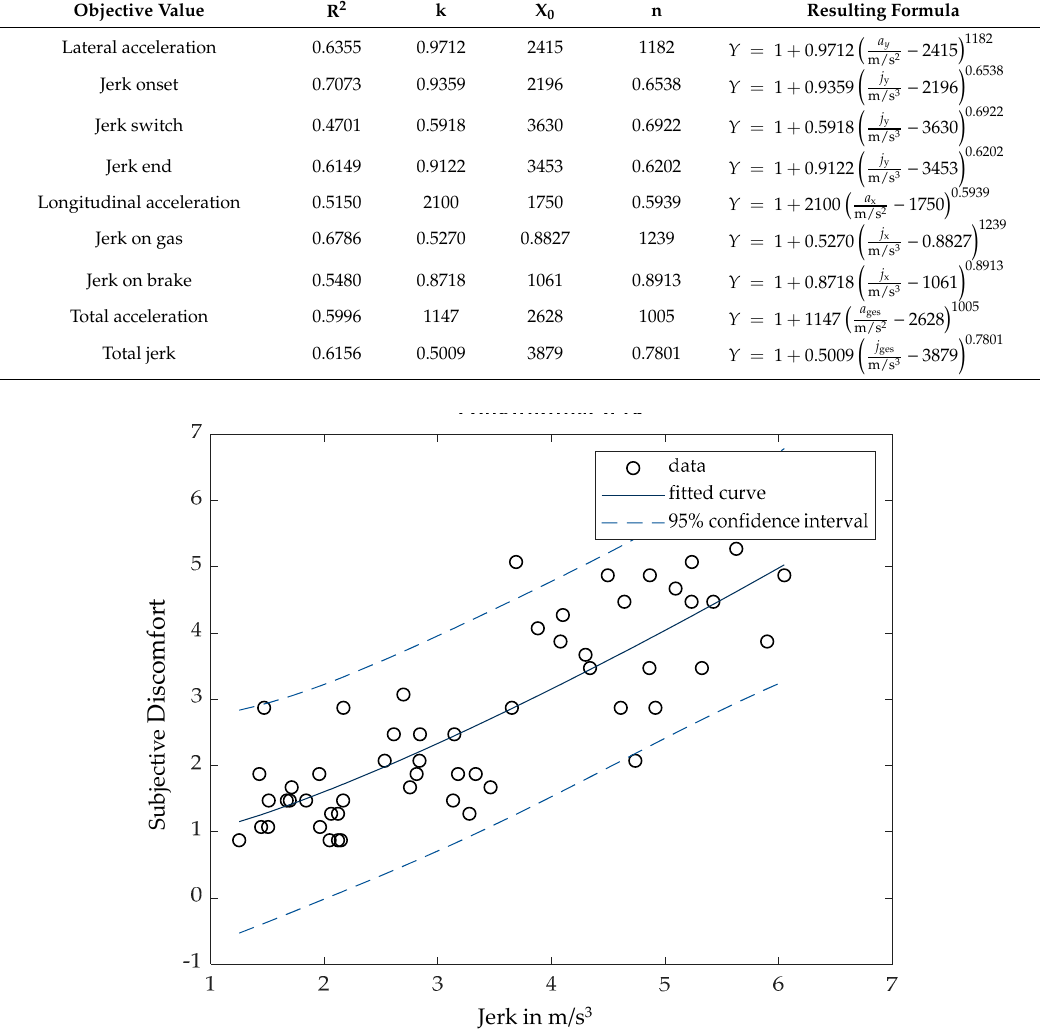
Figure 7. Regression analysis for the objective value longitudinal jerk on gas in Maneuver A.